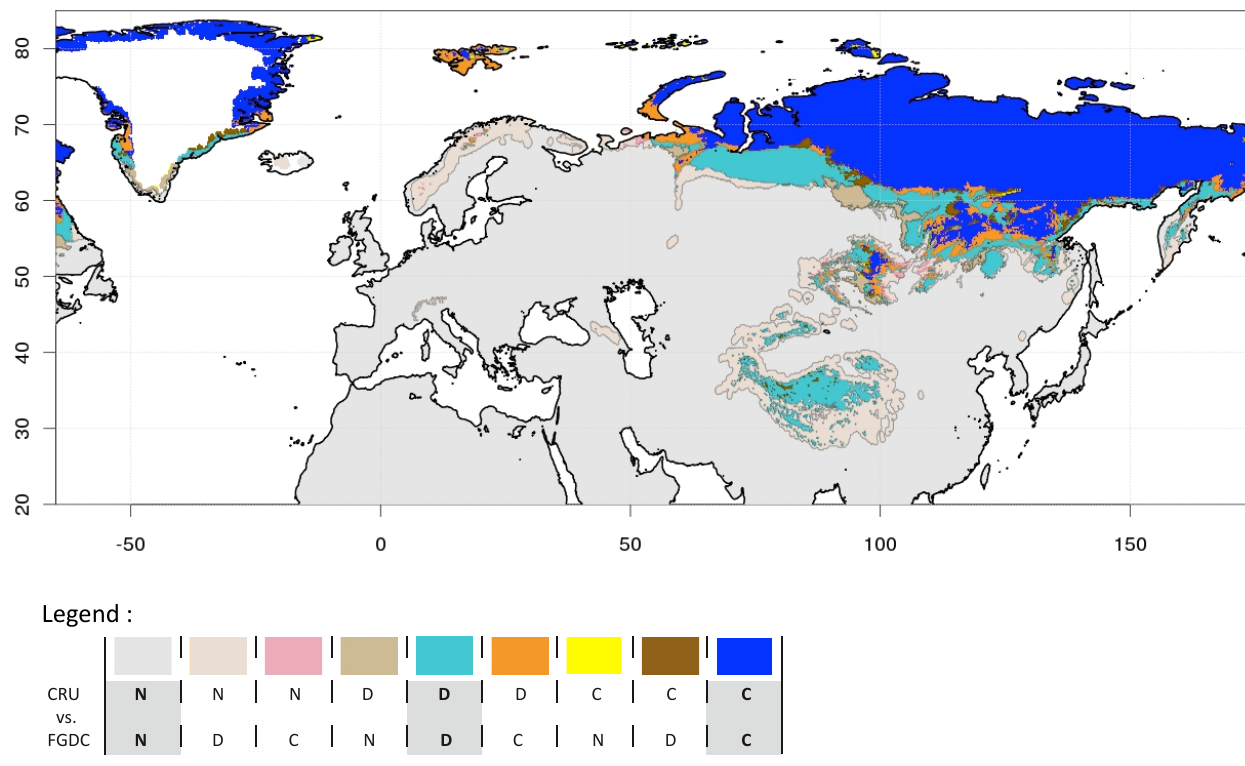
Fig. 1. Permafrost comparison between CRU temperature climatology with the Renssen and Vandenberghe (2003) conditions and the IPA/FGDC permafrost index. In the legend panel,“N” corresponds to “No permafrost”, “D” to “Discontinuous permafrost” and “C” to “Continuous permafrost”. The highlighted categories with bold letters shows the agreement between both